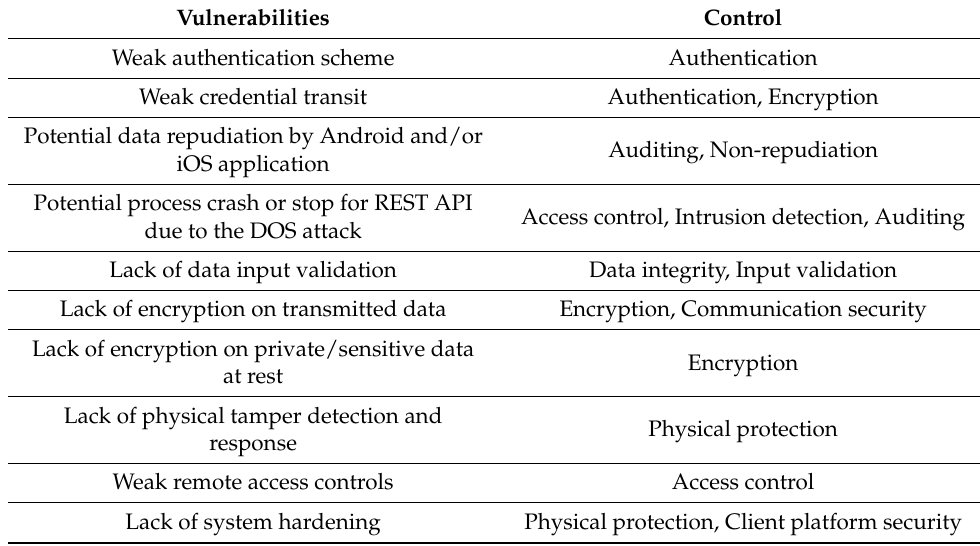
Table 3. Mapping of the control for respective